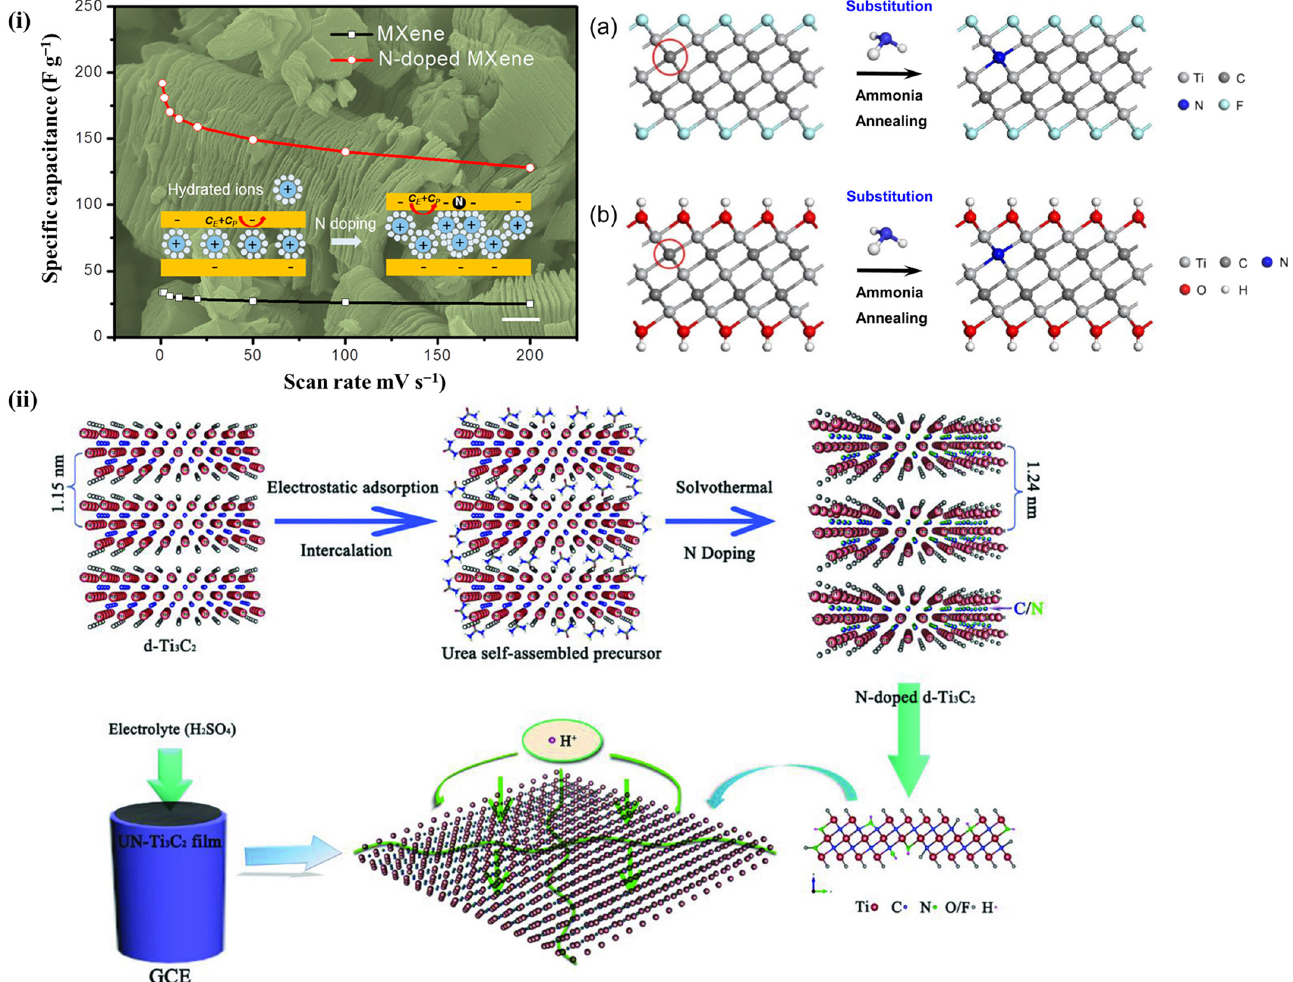
Figure 14. ( i ) An exemplification of charge storage and film-electrode fabrication of UN-Ti 3 C 2 [96]. ( ii ) Schematic illustration of film preparation and electrode fabrication of the UN-Ti3C2. Moreover, Ti 2 CT x -MXene underwent simultaneous liquid-gas phase delamination and chemical doping with nitrogen [97]. Under inert environs, the NH 2 CN utilized as a N-source and intercalant was bonded to the Ti 2 CT x nanosheets, and during heat treatment,